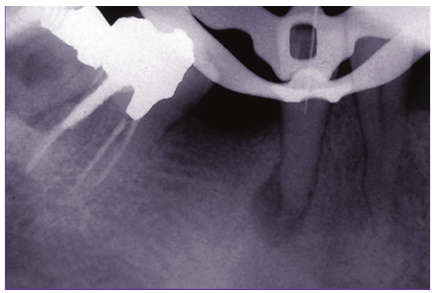
Figure 2: In order to find root canal’s orifice, some working radiographs were taken, but root canal negotiation was impossible.